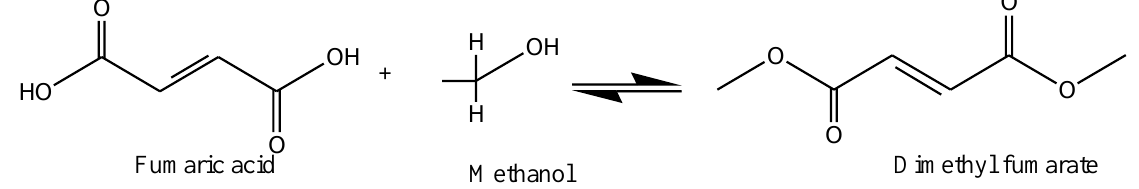
Figure 5 . The chemical reaction between fumaric acid and methanol forms an unsaturated polyester resin (dimethyl fumarate) [53].